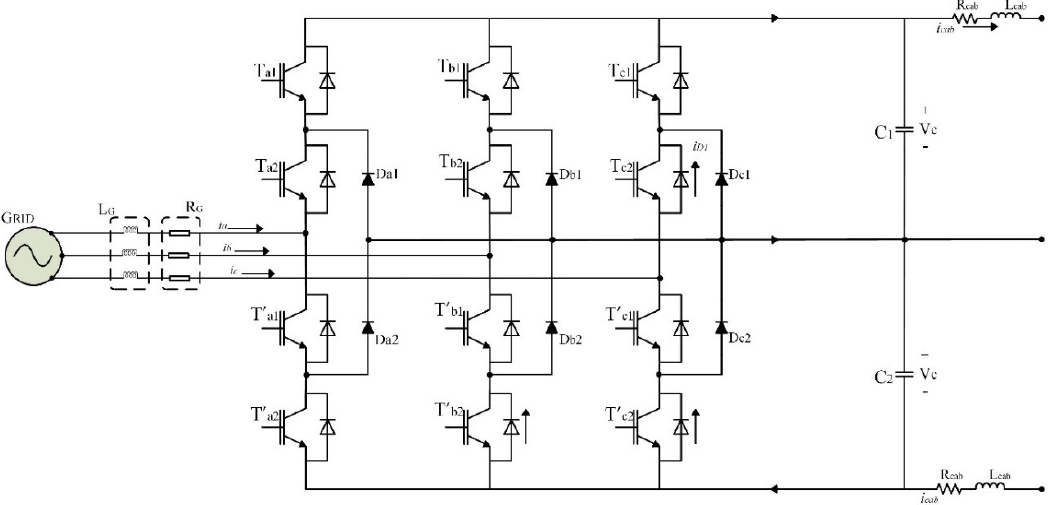
Figure 7. Neutral point clamped (NPC) converter.